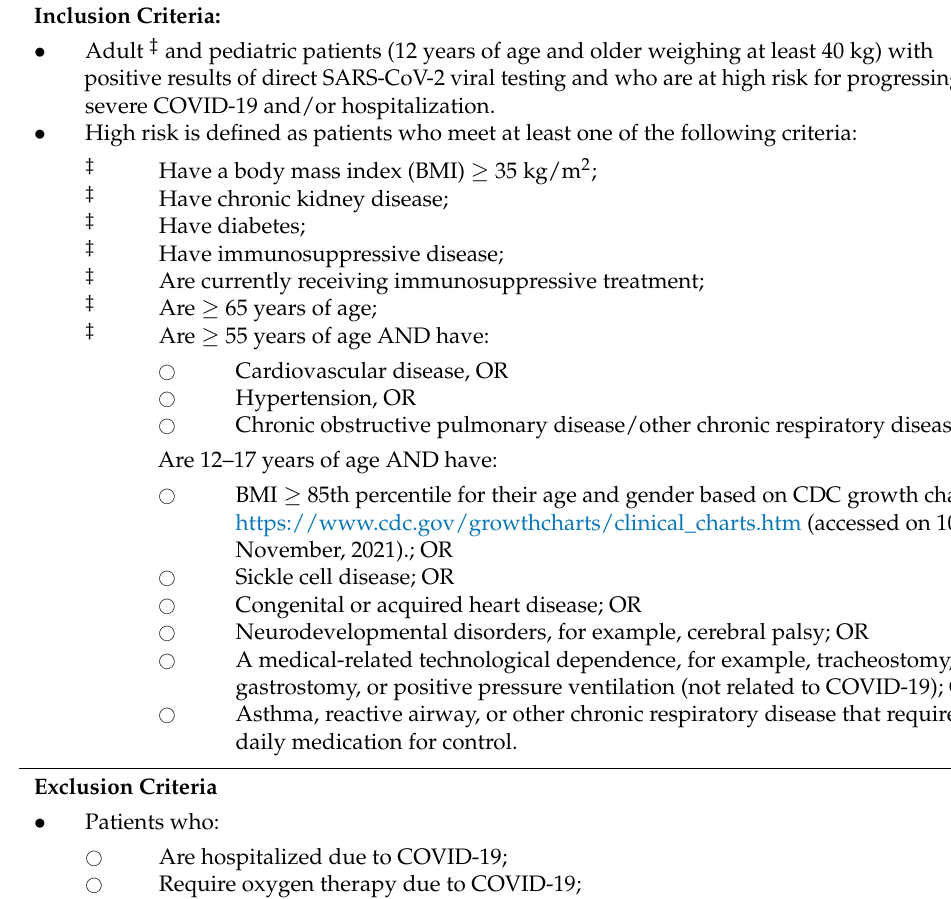
Table 1. Bamlanivimab EUA Inclusion and Exclusion Criteria. The original bamlanivimab EUA criteria only included adult patients (i.e., age ≥ 18 years old). In February 2021, the FDA updated the inclusion criteria to include pediatric patients ≥ 12 years